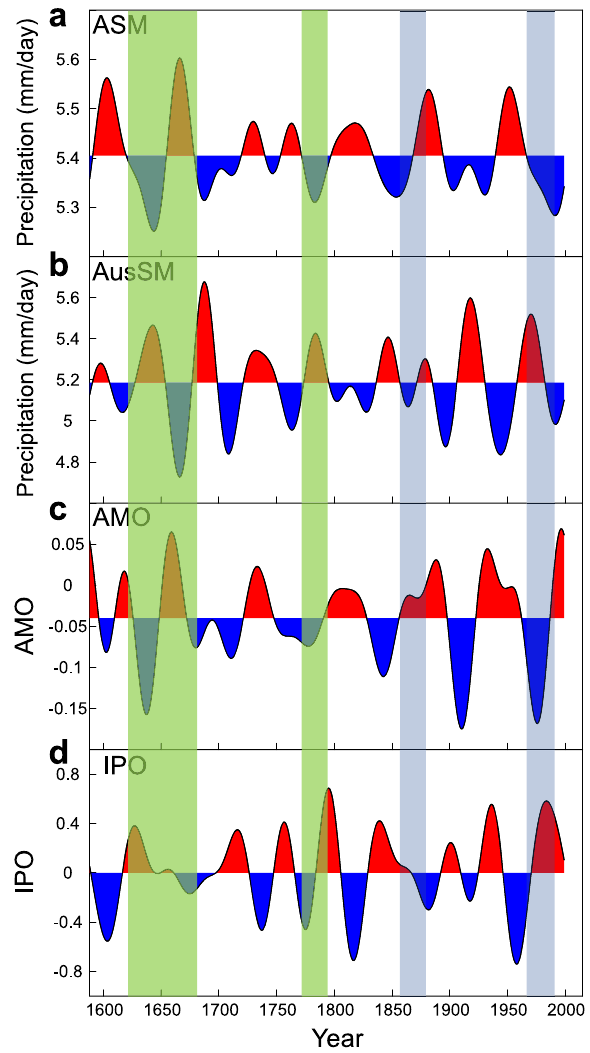
Fig. 5 Multi-decadal variations of monsoon precipitation and internal variability. a ASM precipitation. b AusSM precipitation . c AMO 21 . d IPO 60 – 62 .